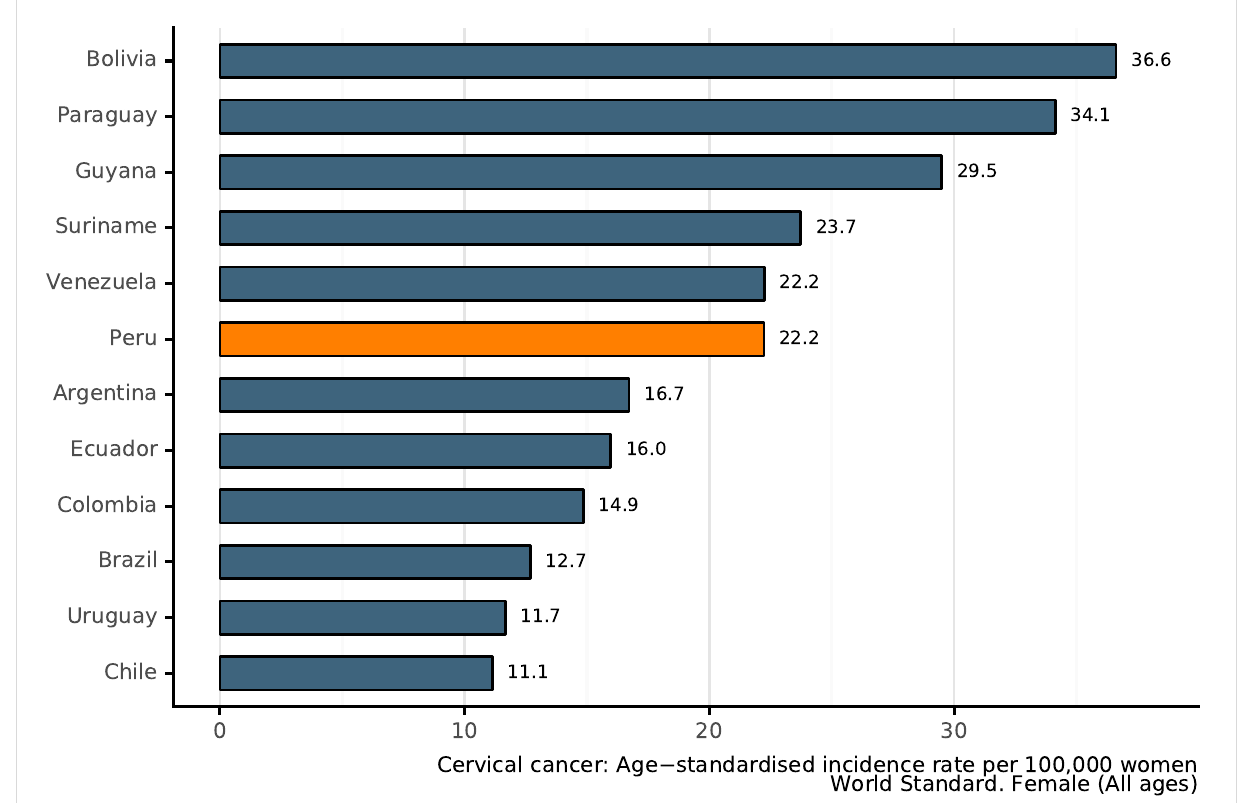
Cervical cancer: Age standardised incidence rate per 100,000 women World Standard. Female (All